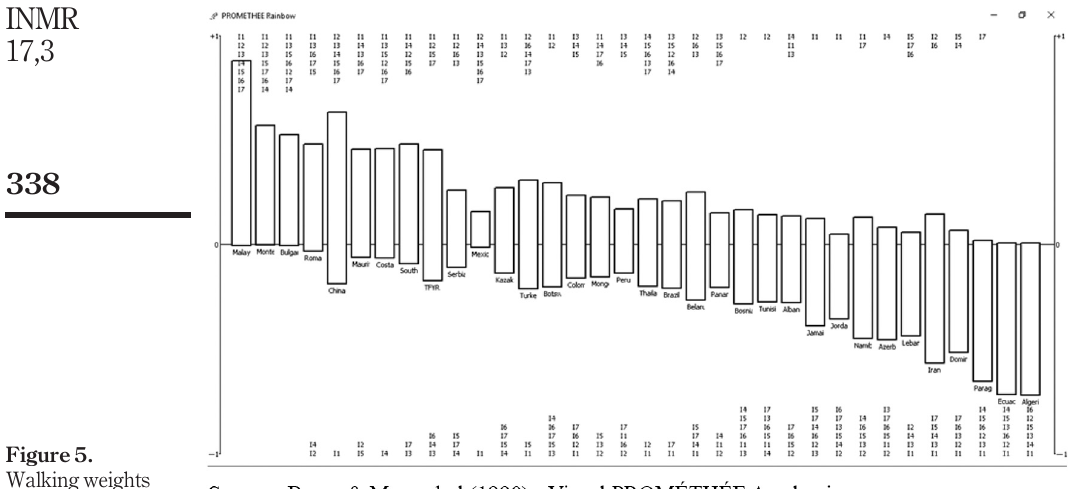
Figure 5. Walking